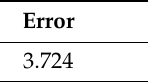
Table 5. Summary of the performance of the